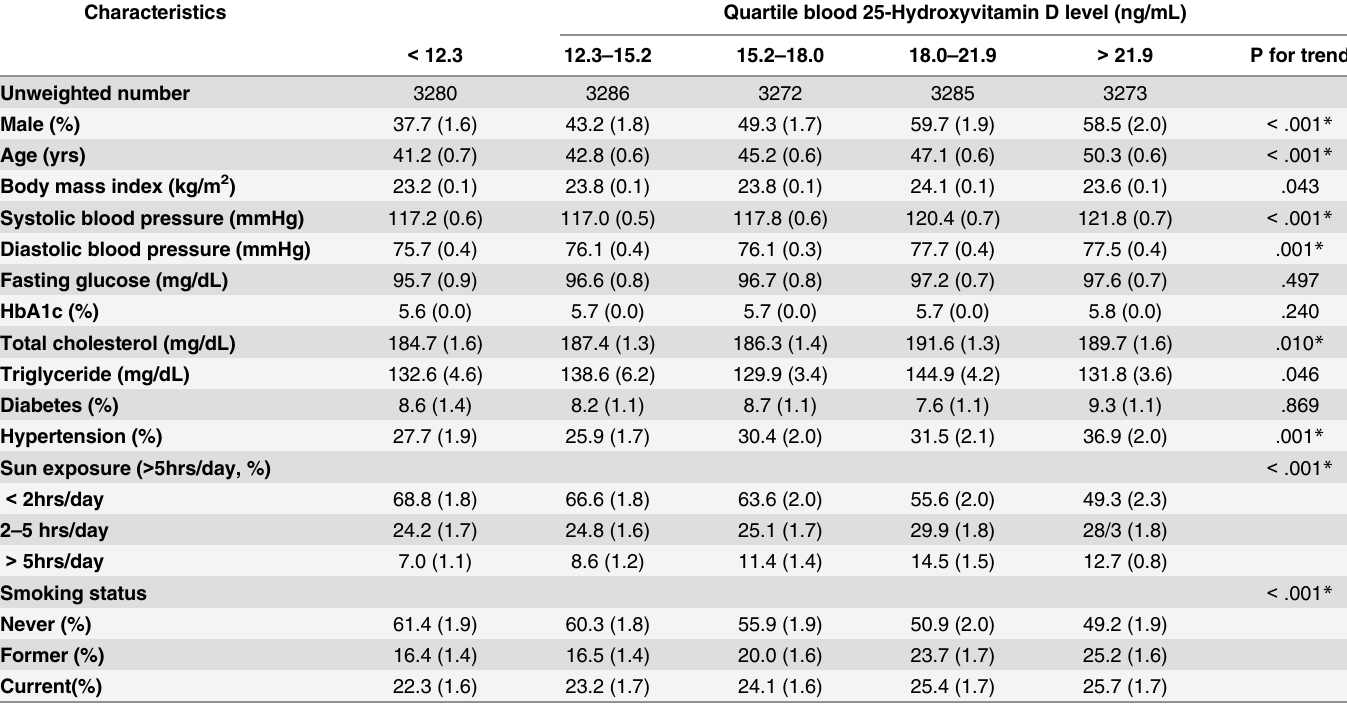
Table 2. Demographic and clinical characteristics by quartile blood 25-Hydroxyvitamin D categories among representative Korean adults aged 19 years or older.